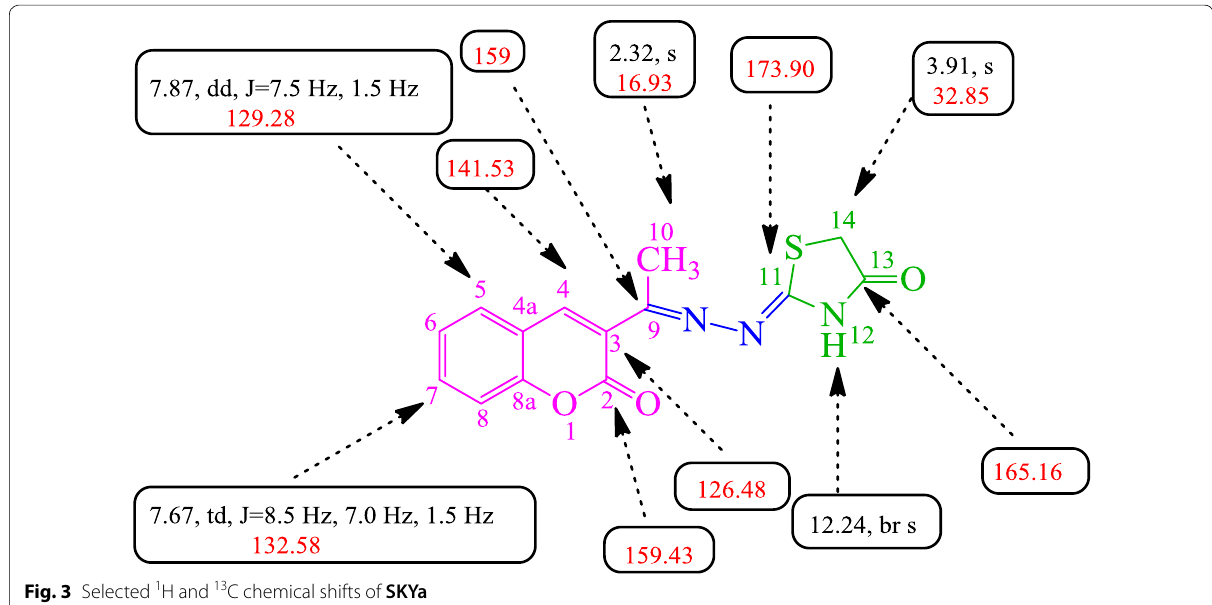
Fig. 3 Selected 1 H and 13 C chemical shifts of SKYa